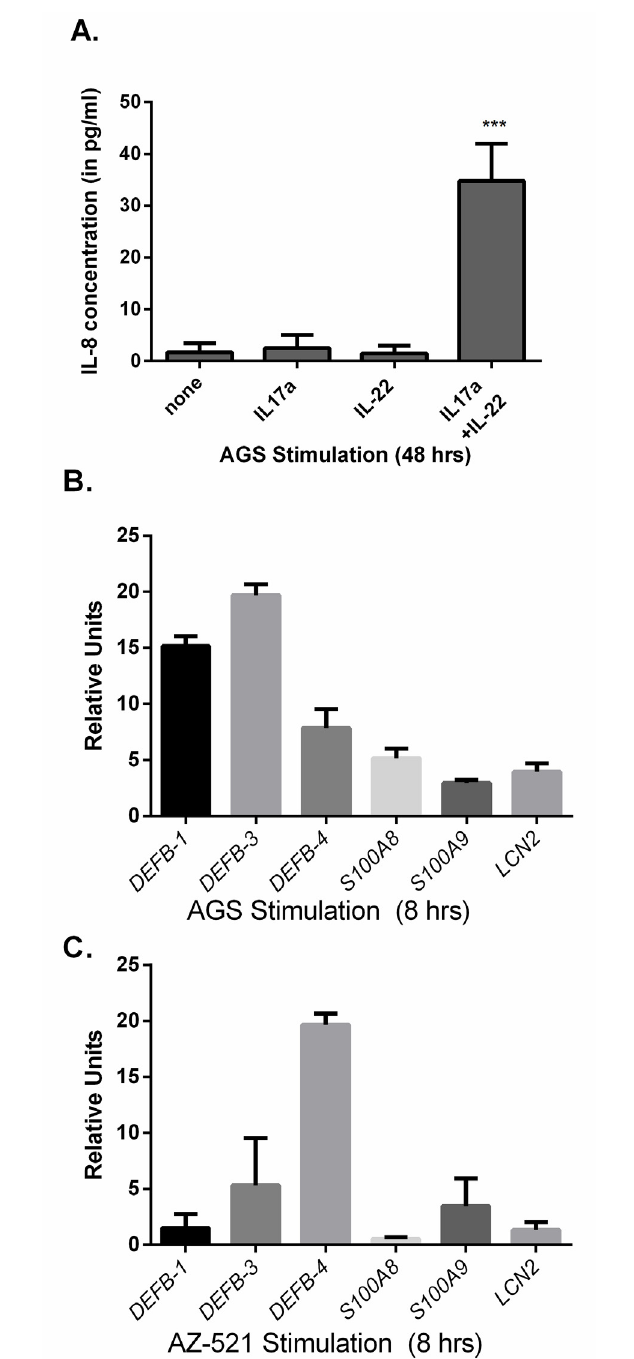
Fig 1. IL-17A and IL-22 synergistically stimulated human epithelial cells inducing IL-8. (A) IL-8 production at 24 hours by AGS cells in response to IL-22 and IL-17A as measured by ELISA. p-value is based on ANOVA test with Dunnett ’ s correction for multiple comparisons *** p < 0.001. (B) 8 hour stimulation of AGS cells or (C) AZ-521 cells with an IL-22/IL-17A cocktail induces upregulation of antimicrobials as measured by real-time rtPCR. Expression is shown as relative units and is relative to RNA from untreated cells. Data shown as ± SEM and are representative of 3 independent experiments.